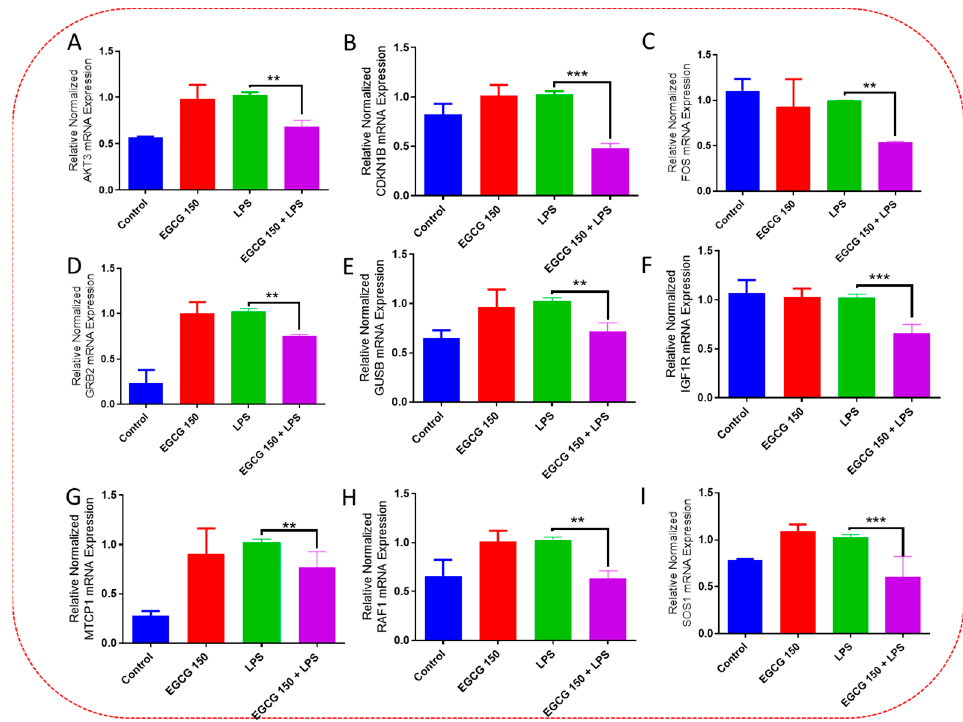
Figure 10. EGCG downregulated inflammatory-associated PI3k-AKT genes. PCR array inquiry displayed EGCG 150 µ M coupled with LPS (1 µ g/mL) decreased mRNA expression of the genes AKT3 ( A ), CDKN1B ( B ), FOS ( C ), GRB2 ( D ), GUSB ( E ), IGF1R ( F ), MTCP1 ( G ), RAF1 ( H ), and SOS1 ( I ) compared to LPS. Values represent the mean ± SD, ** p ≤ 0.01, and *** p ≤ 0.001 vs. LPS.